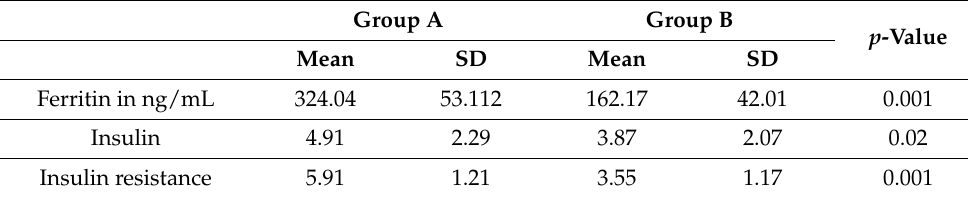
Table 3. Showing the mean levels of ferritin, serum insulin and insulin resistance in both groups. Group